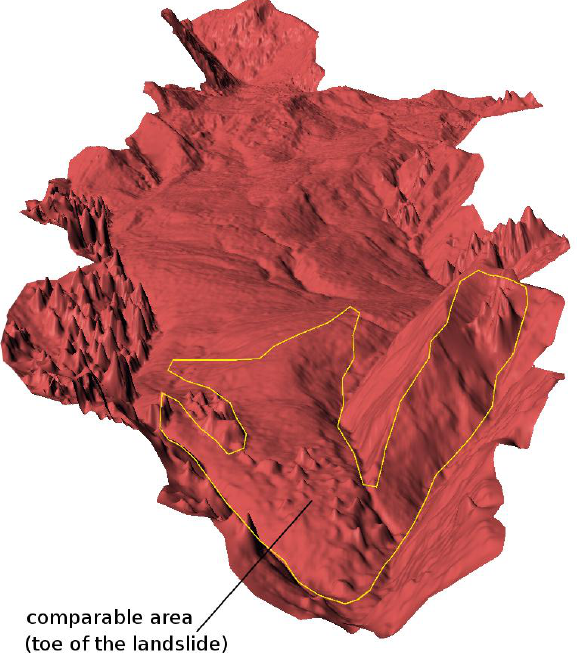
Figure 5. DTM of the entire Super-Sauze landslide (0.3 m grid)